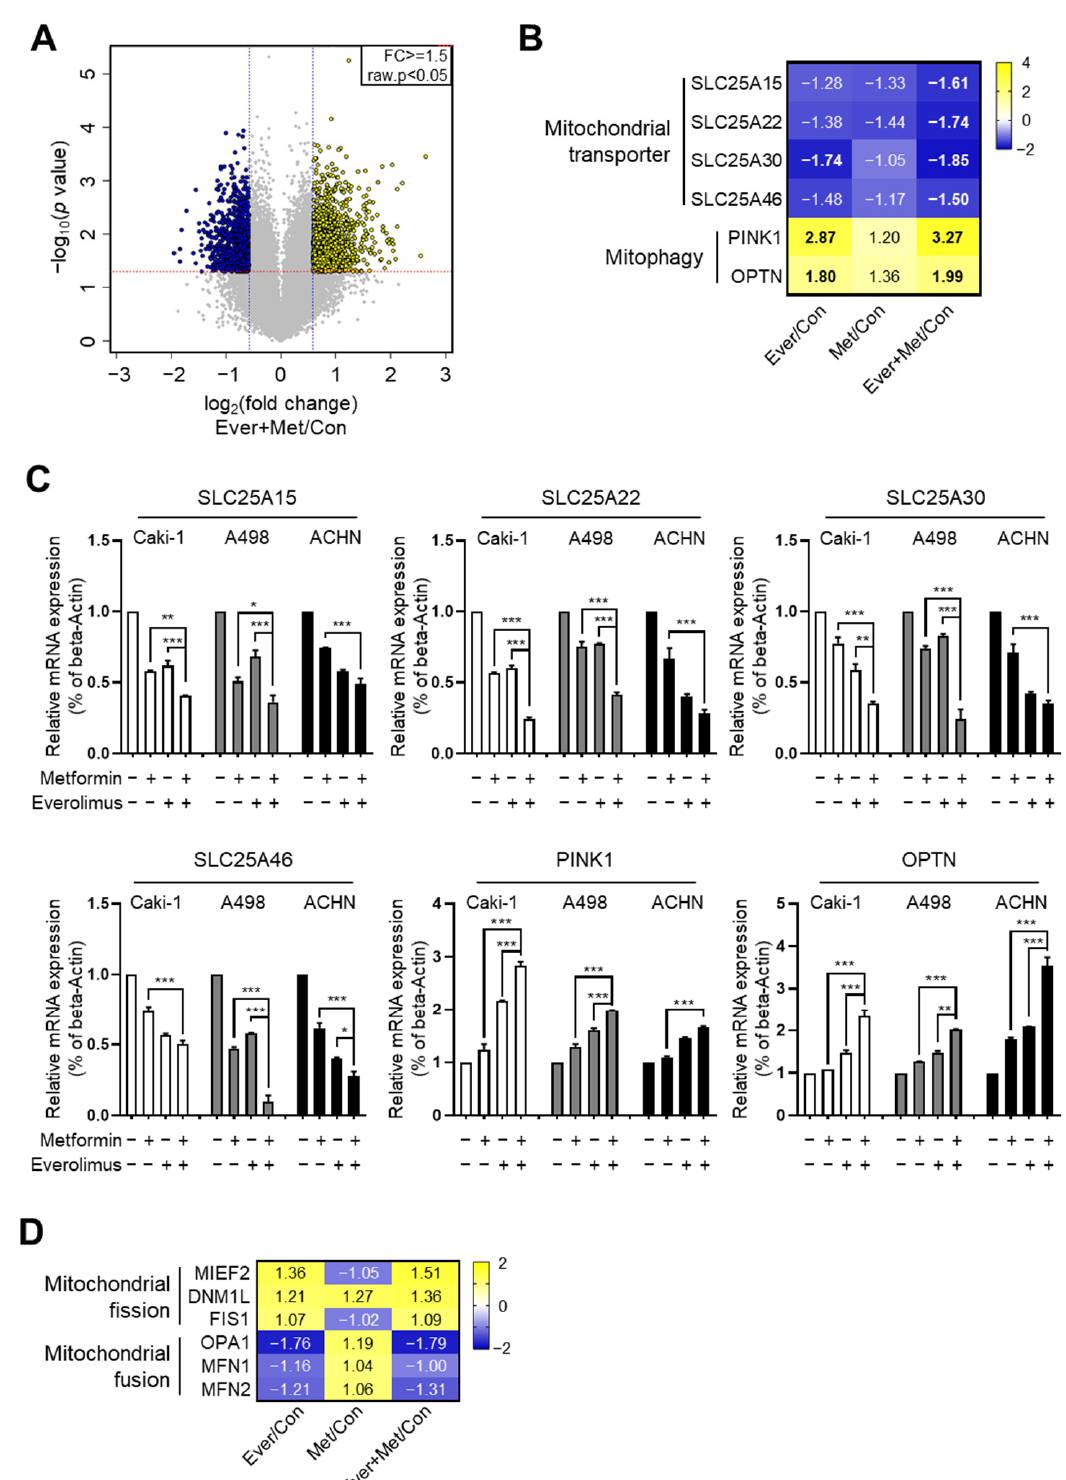
Figure 2. Synergistic effects of the combination treatment of metformin and everolimus induced mitochondrial dysfunction: ( A ) Volcano plot illustration of differentially expressed genes under the combination treatment; ( B ) Heat map visualization of six differentially regulated genes related to mitochondrial transporters and mitophagy; ( C ) qRT-PCR for SLC25A15, SLC25A22, SLC25A30, SLC25A46, PINK1, and OPTN treated with the control, metformin, everolimus, and combination of the drugs in Caki-1, A498, and ACHN cells. Data are presented as the mean ± standard error of the mean. * p < 0.05; ** p < 0.01; and *** p < 0.001 vs. combination treatment group of metformin and everolimus; ( D ) Heat map visualization of six differentially regulated genes related to mitochondrial fusion-fission. 3.4. Combination Treatment Modulates the Mitochondria Fusion-Fission Cycle Because mitophagy occurs after mitochondrial fission, we hypothesized that the combination treatment might also affect mitochondrial dynamics. To identify the effect of the combination treatment on mitochondrial dynamics, we examined mitochondrial fu-